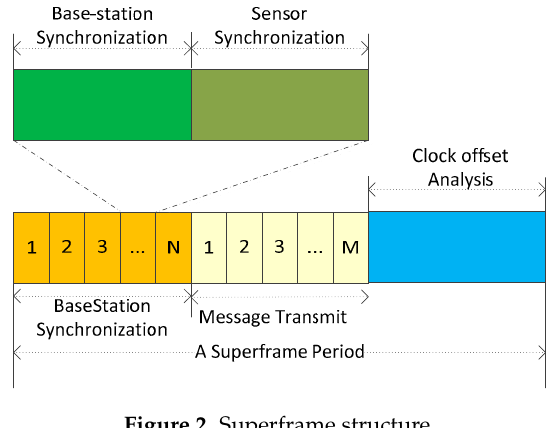
Figure 2. Superframe structure.